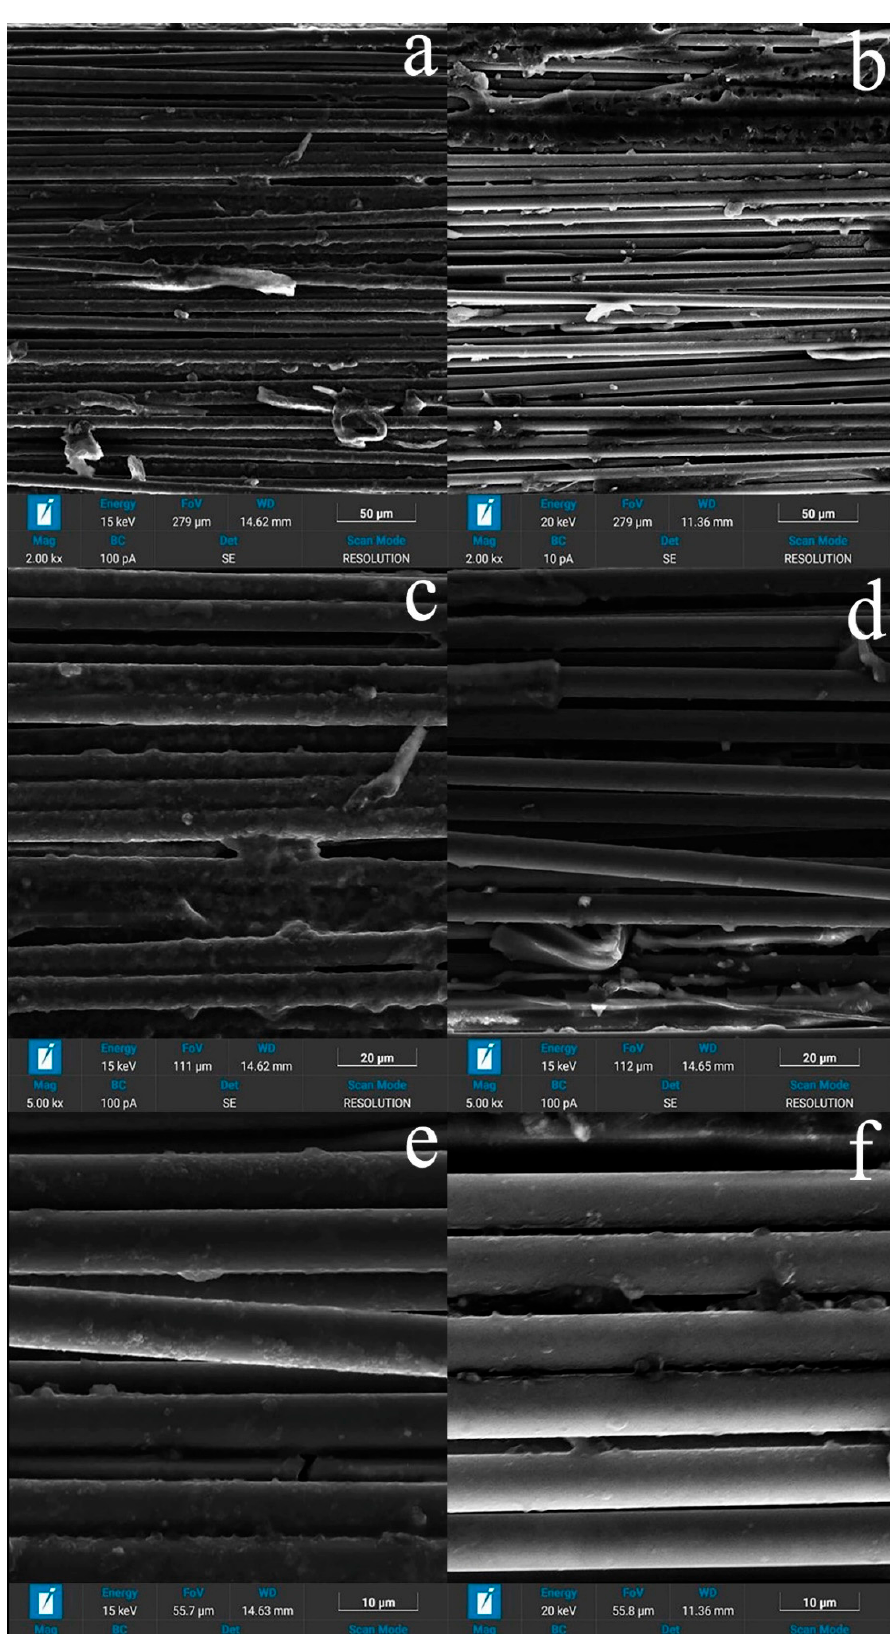
Figure 7. Surface destruction of the microcomposite CF–PSU. ( a , c , e ) Toray T700 high-strength fiber ( b , d , f ) UMT400 high-modulus fiber.